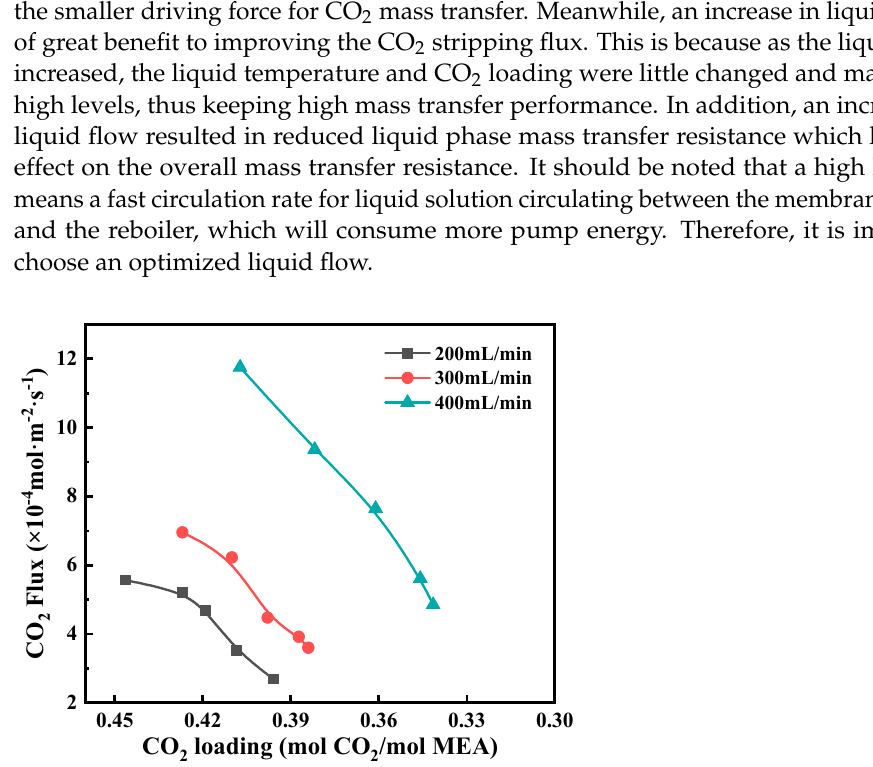
Figure 9. The effect of CO 2 loading on CO 2 flux at different liquid flow rates. Experimental conditions: T = 373 K, P = 60 kPa, C MEA = 5.0 mol/L.